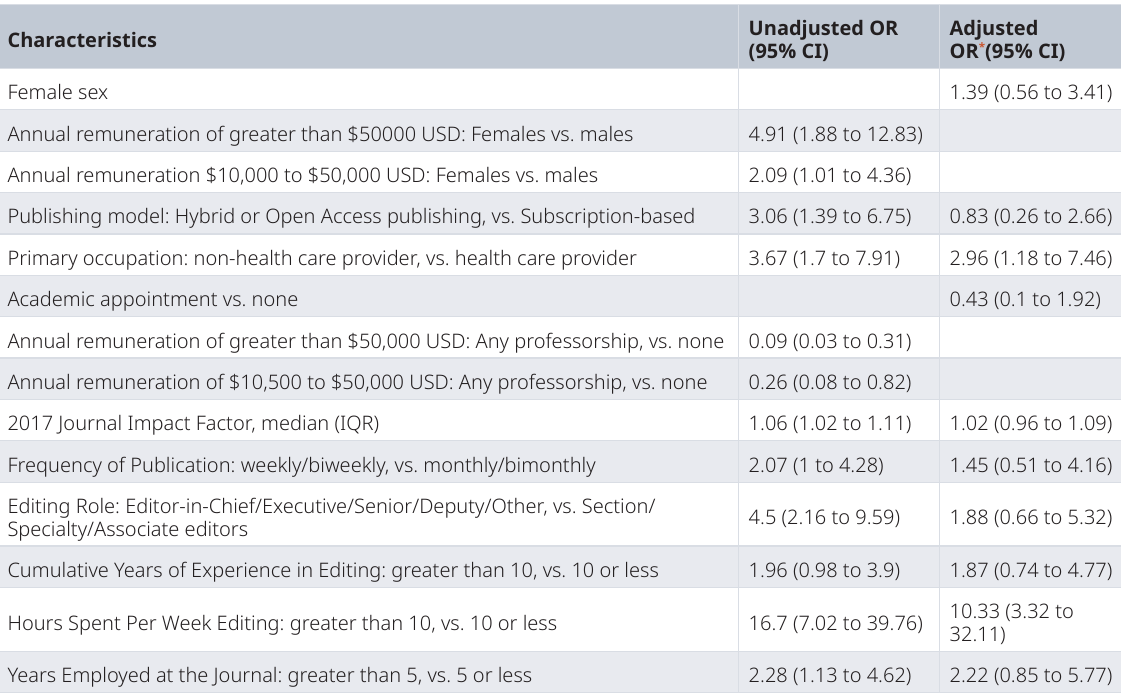
Table 2. Association between editor characteristics and remuneration.